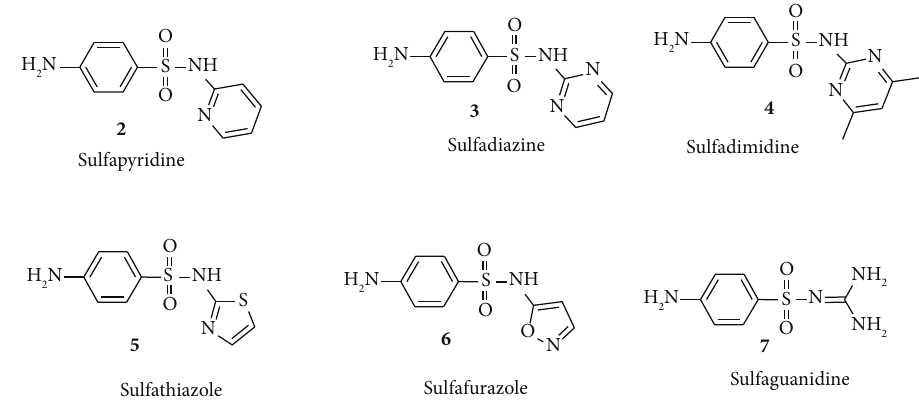
Figure 2: Chemical structures of sulfa drugs derivatives.